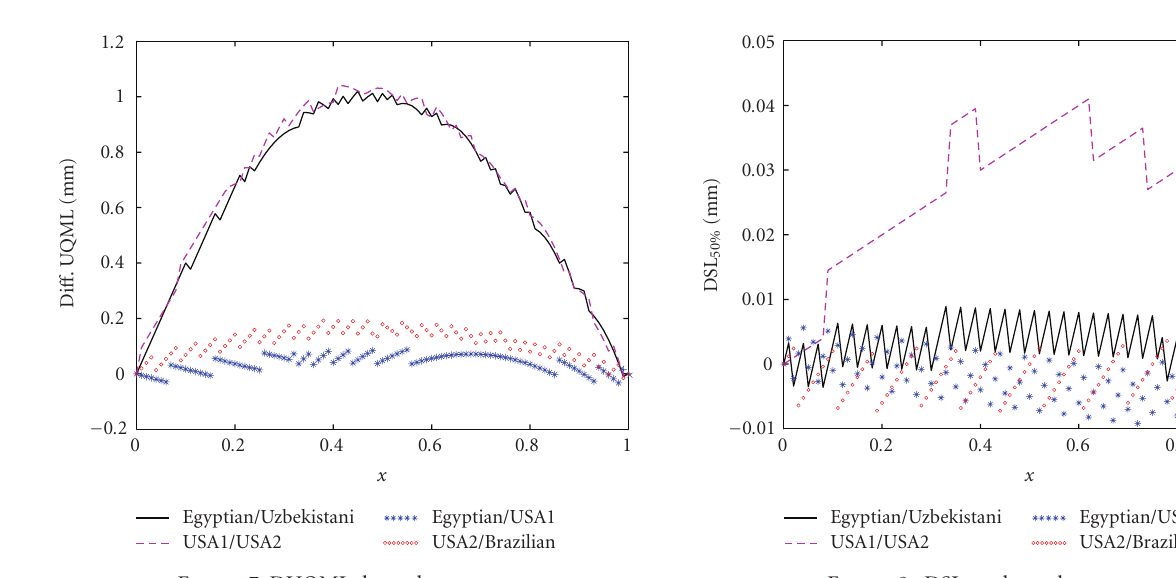
Figure 7: DUQML dependence to x .